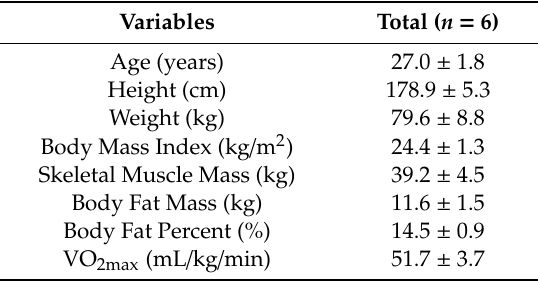
Table 1. Characteristics of the participants.